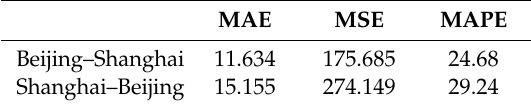
Table 3. Global volume error analysis for both